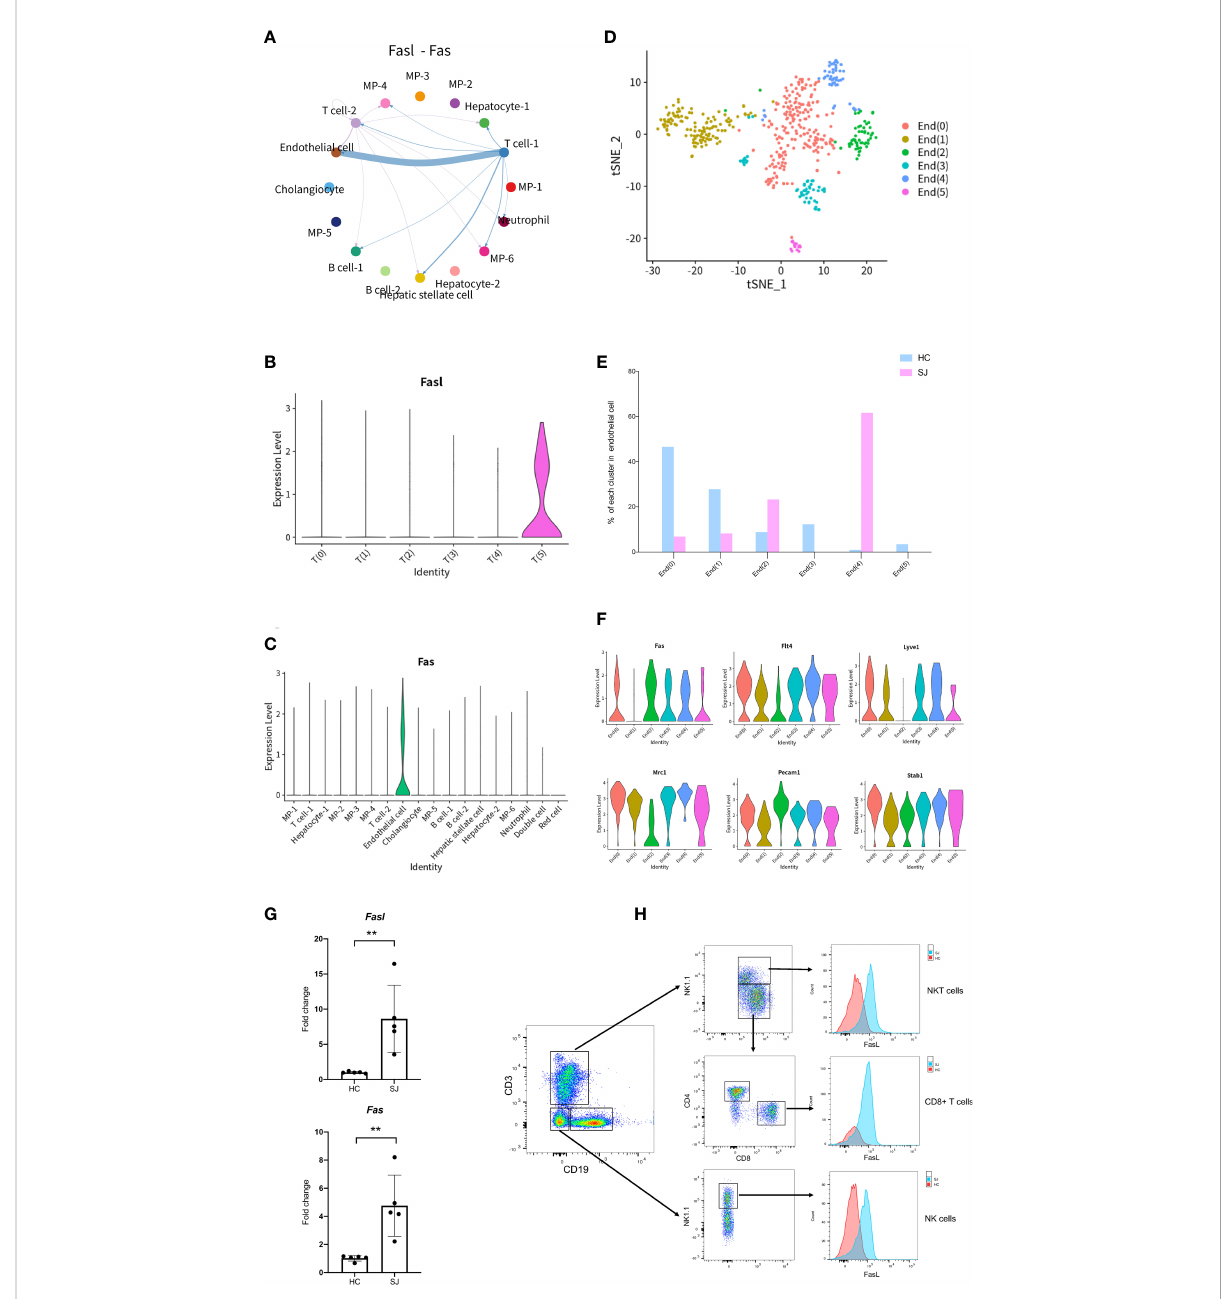
FIGURE 6 FASLG signaling pathway in fi brotic liver of schistosomiasis japonica. (A) Circle plots displaying the Fasl-Fas signaling network between different cell clusters. (B) Violin plots of Fasl in each T cells cluster. (C) Violin plots of Fas in different cells cluster. (D) tSNE plots of endothelial cells for six clusters. (E) The percentage change tendency of each endothelial cells cluster in two groups. (F) Violin plots of genes in each endothelial cells cluster. (G) The qPCR of Fasl and Fas in schistosome- fi brotic livers(n=5) and normal livers(n=5). The signi fi cance level was tested by unpaired t test and the data are shown as the mean ± s.d value (*p < 0.05; **p < 0.01; ***p < 0.001; ****p < 0.0001). (H) The expression of FasL in NKT cells, CD8 + T cells and NK cells. Gating strategy for the identi fi cation of T cells (CD3+CD19-NK1.1-), B cells(CD19+CD3-NK1.1-), NK cells(NK1.1+CD3-CD19-), NKT cells(CD3+NK1.1+), CD4+ T cells(CD3+CD4+NK1.1-) and CD8+ T cells(CD3+CD8+NK1.1-) (gated on live cells and CD45+